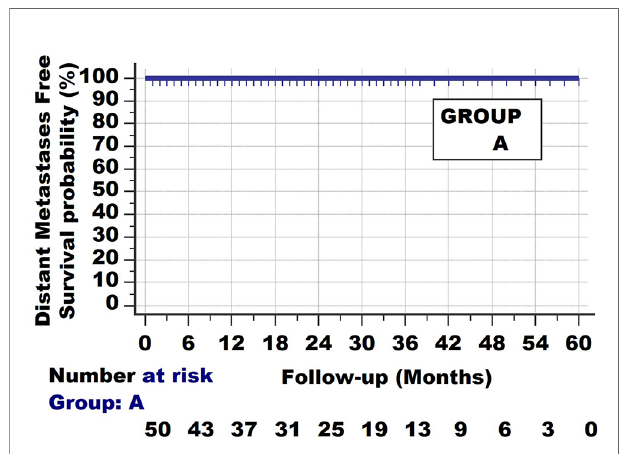
FIGURE 1 | Invasive cancer group A. Survival curve with long follow-up. None of the patients develop/die from metastatic disease.